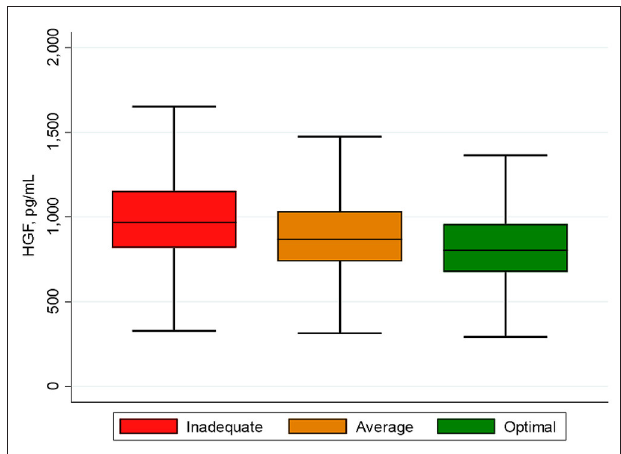
TABLE 2 | Associations between cardiovascular health and hepatocyte growth factor in MESA (2000–2002), N = 6,490.